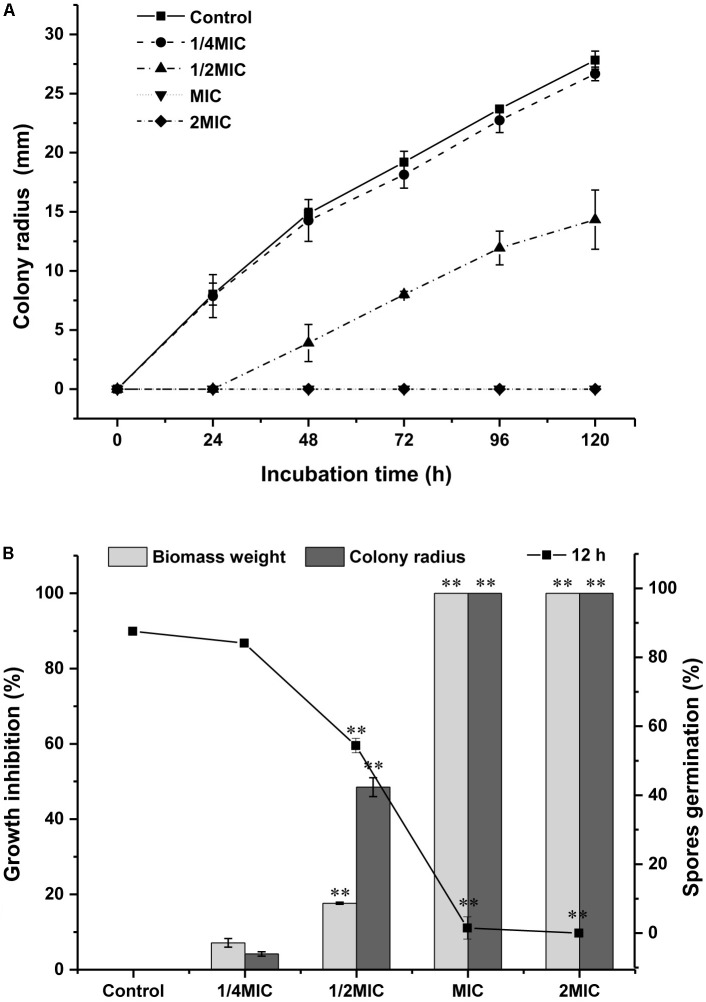
Effect of Cin/Cit on the mycelial growth and spore germination of Penicillium expansum F-WY-12-02. (A) Colony radius. (B) Spore germination (%) at 12 h, growth inhibition (%) for biomass weight and colony radius. ∗∗p < 0.01.